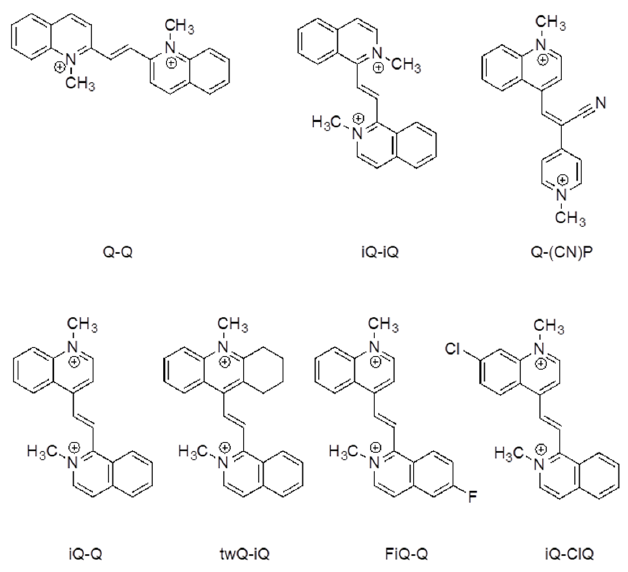
Figure 1. Quinolinium (Q) and isoquinolinium (iQ) substituted ethene derivatives prepared and characterized in this work.